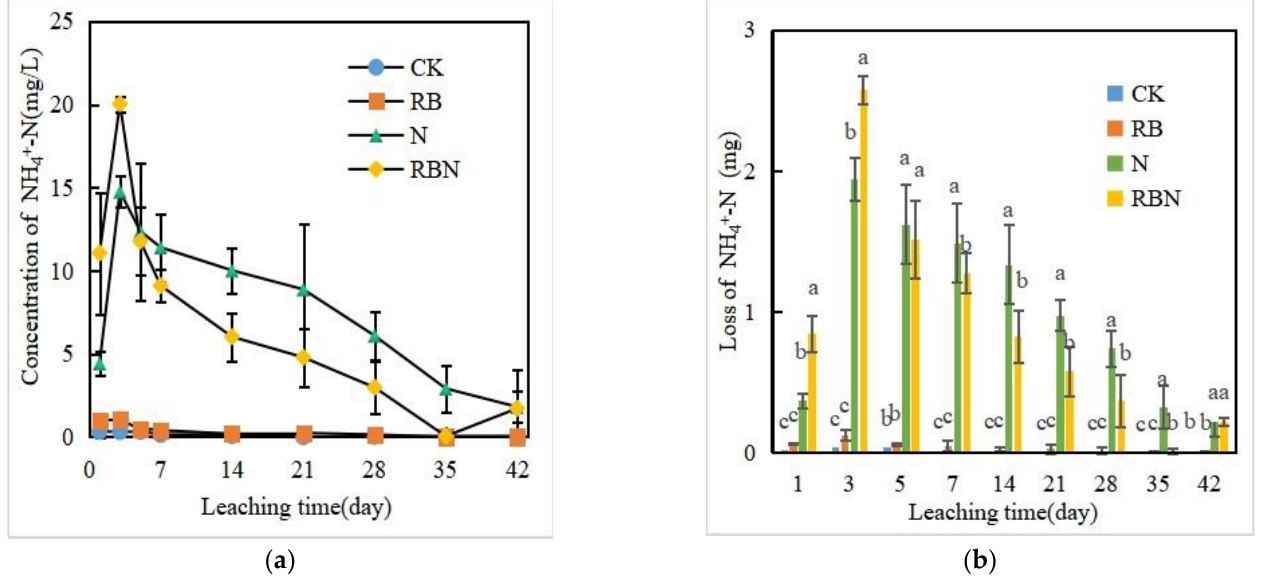
Figure 2. ( a ) Concentration of NH 4+ -N in leachate; ( b ) loss of NH 4+ -N in leachate. Different letters in the image(b) indicate significant differences between treatments (p < 0.05).